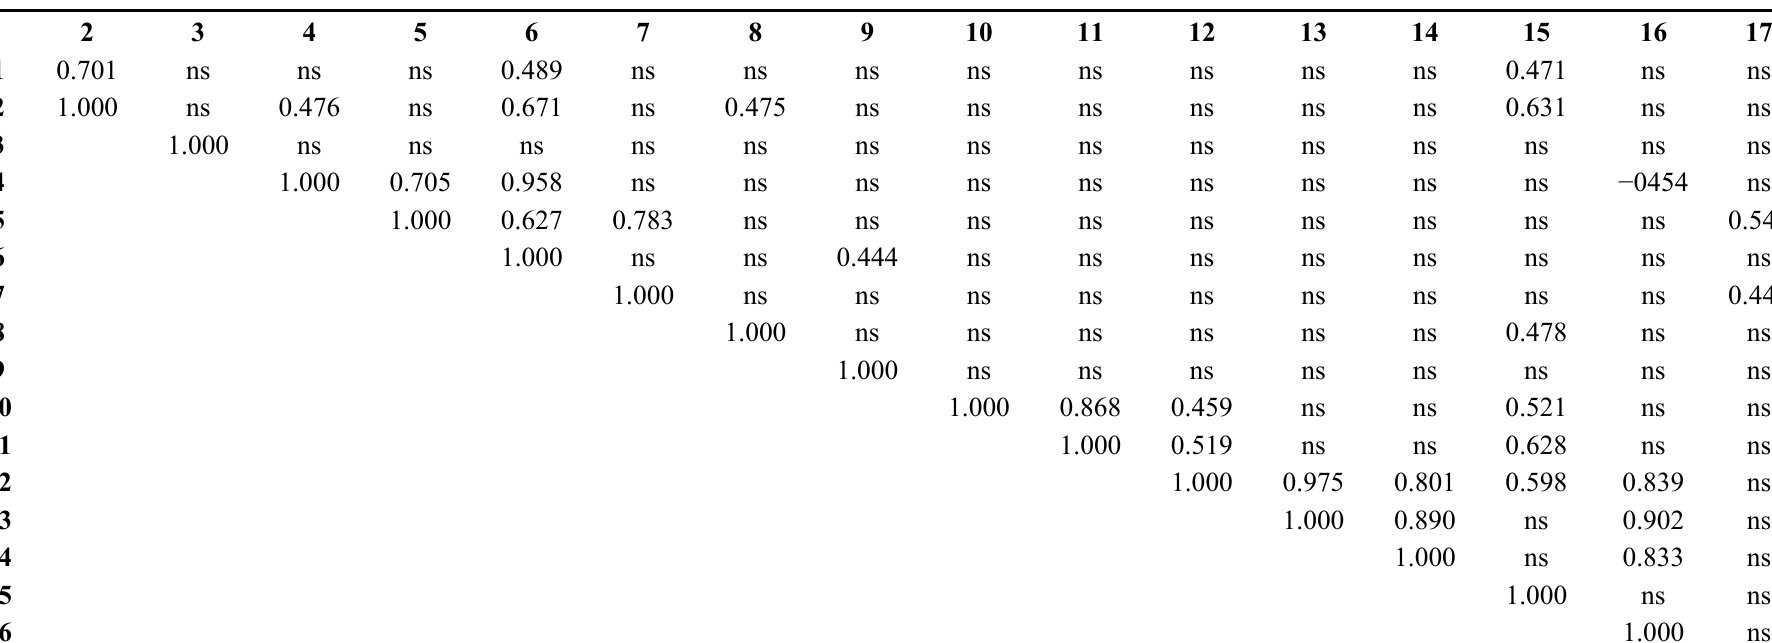
Table 4. Values of stress index of gas exchange, pigment contents, parameters of photochemical efficiency (PSII) of seedling and final weight of seeds after drought